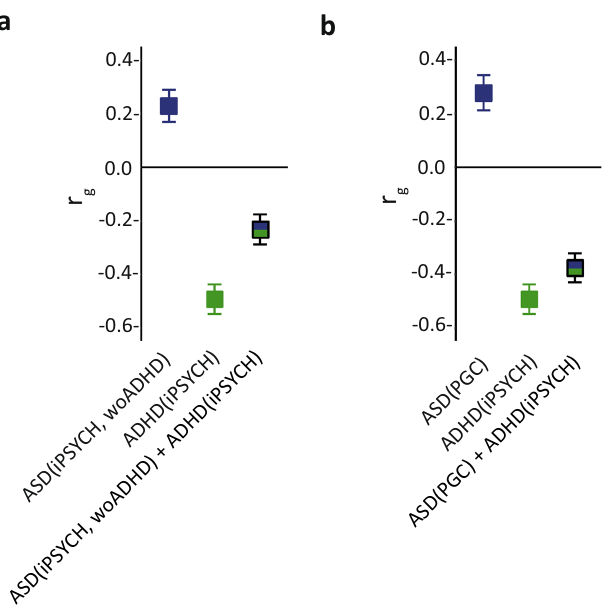
Fig. 3 Genetic correlations with educational attainment for ASD + ADHD cross-disorder meta-analyses. Genetic correlations ( r g ) of educational attainment (EA) with ASD, ADHD and combined ASD + ADHD risk were estimated using unconstrained Linkage Disequilibrium Score correlation 67